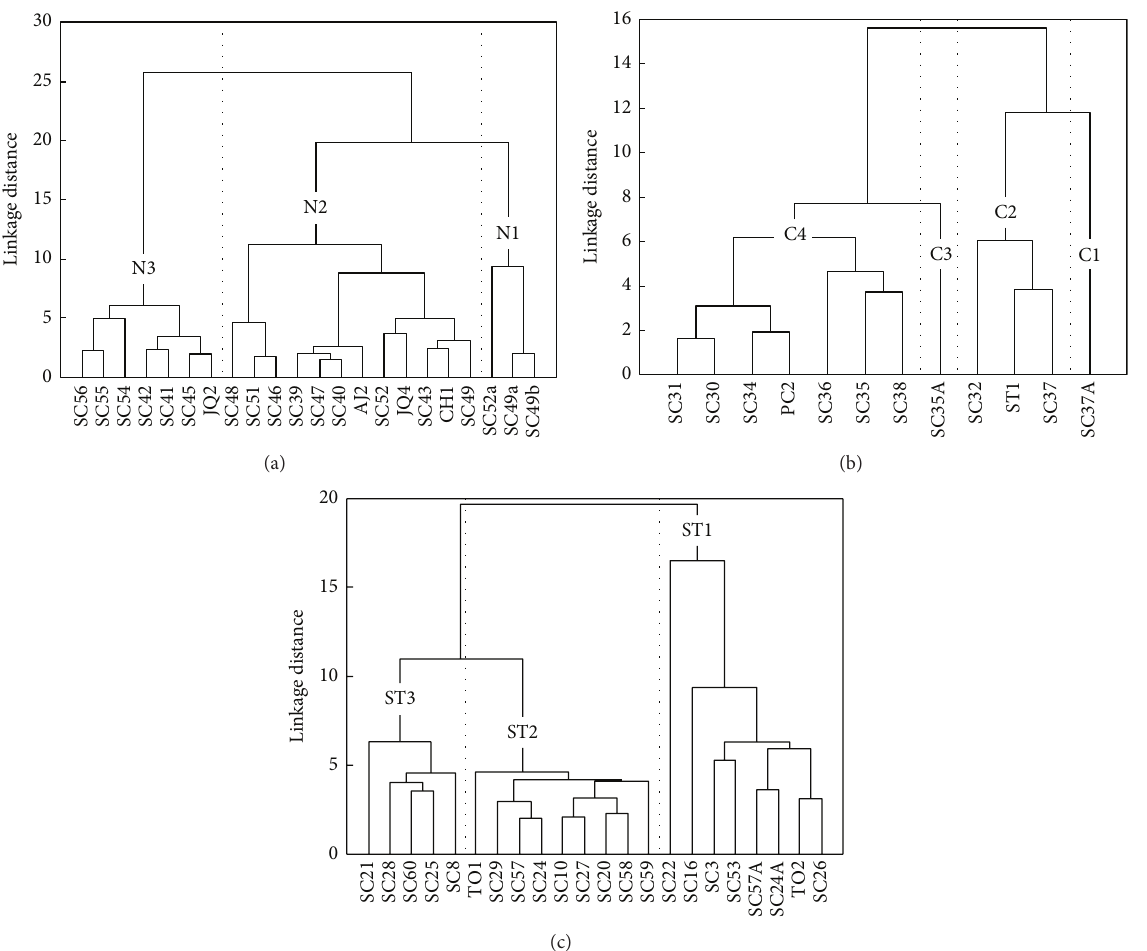
Figure 9: Dendrograms showing the results of the cluster analysis (considering Euclidean linkage distances) for the volcanic rocks from the (a) northern, (b) central, and (c) south + transition Sierra de las Cruces